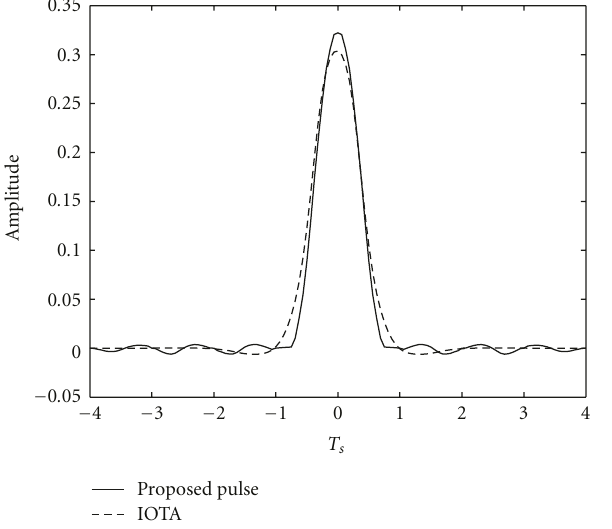
Figure 2: Pulse-shapes in the time domain for symbol rate 10M/sec.